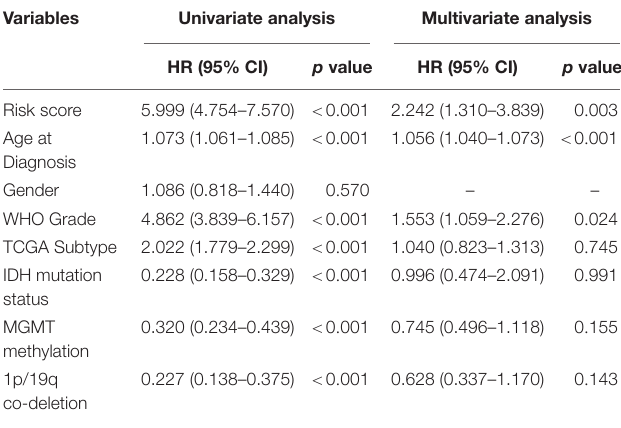
TABLE 2 | Univariate and multivariate analysis of OS in TCGA sequencing